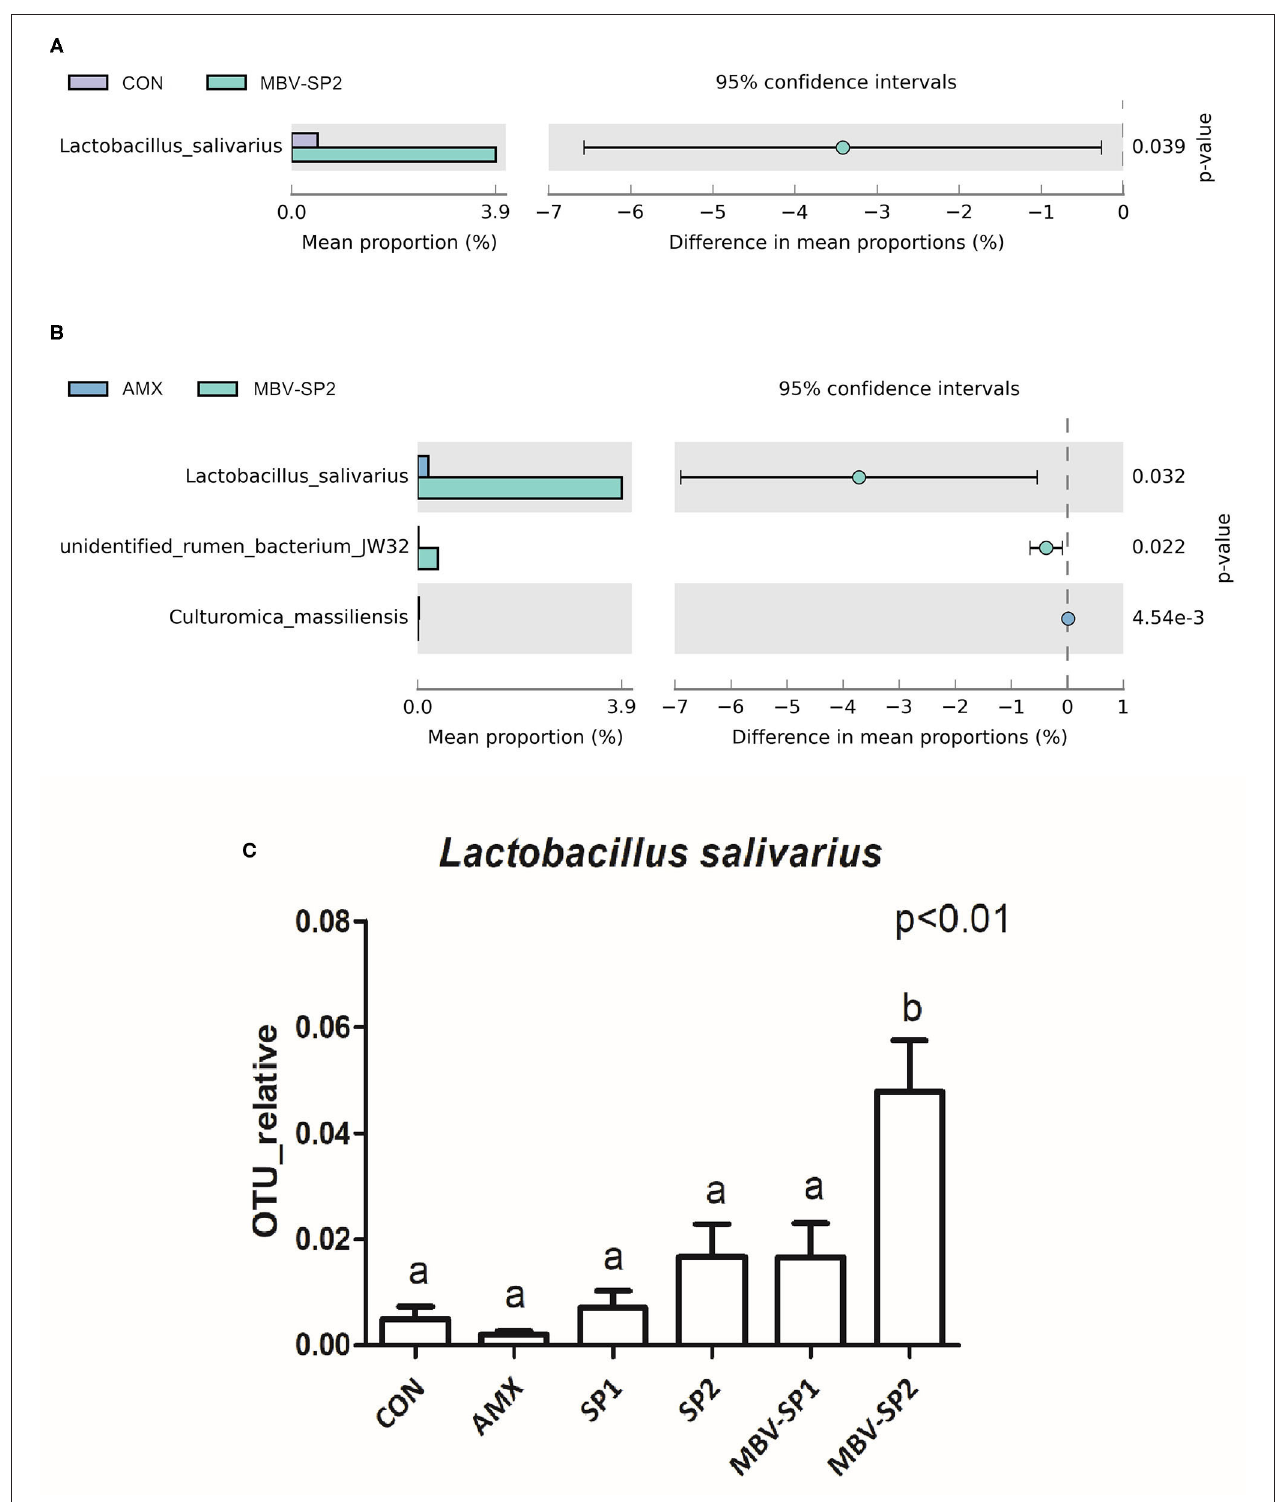
FIGURE 4 | (A) The Welch’s test of group CON and MBV-SP2, (B) The Welch’s test of group AMX and MBV-SP2, (C) The OTU relative abundance of Lactobacillus salivarius after feeding with basal diet (CON), AMX, SP1, SP2, MBV-SP1, and MBV-SP2. Data were presented as mean ± S.D. and subjected to one-way ANOVA. The mean differences were compared using Tukey’s multiple comparison test. Different letters indicate significant differences between treatments. Significance was declared when the probability was < 5% ( P < 0.05; n = 5/each group).